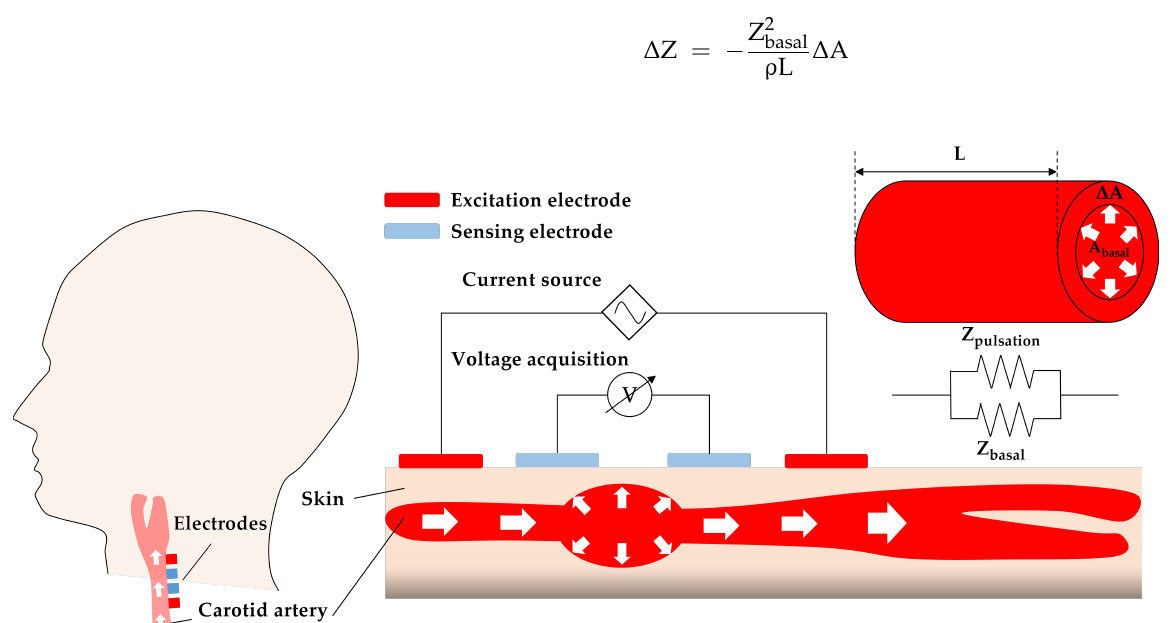
Figure 2. Schematic of IPG-based carotid pulse sensing and equivalent electrical